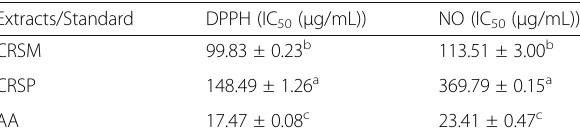
Table 3 DPPH and NO radical scavenging assay of extracts of C. renigera seed Extracts/Standard